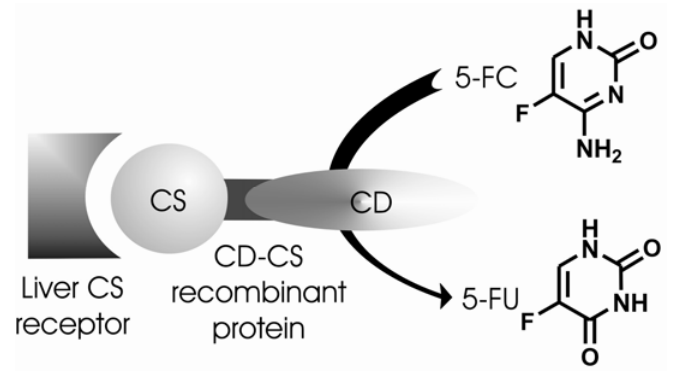
Figure 30. CD-CS approach. Conversion of 5-fluorocytosine (5-FC) into 5-fluorouracil (5-FU) by cytosine deaminase